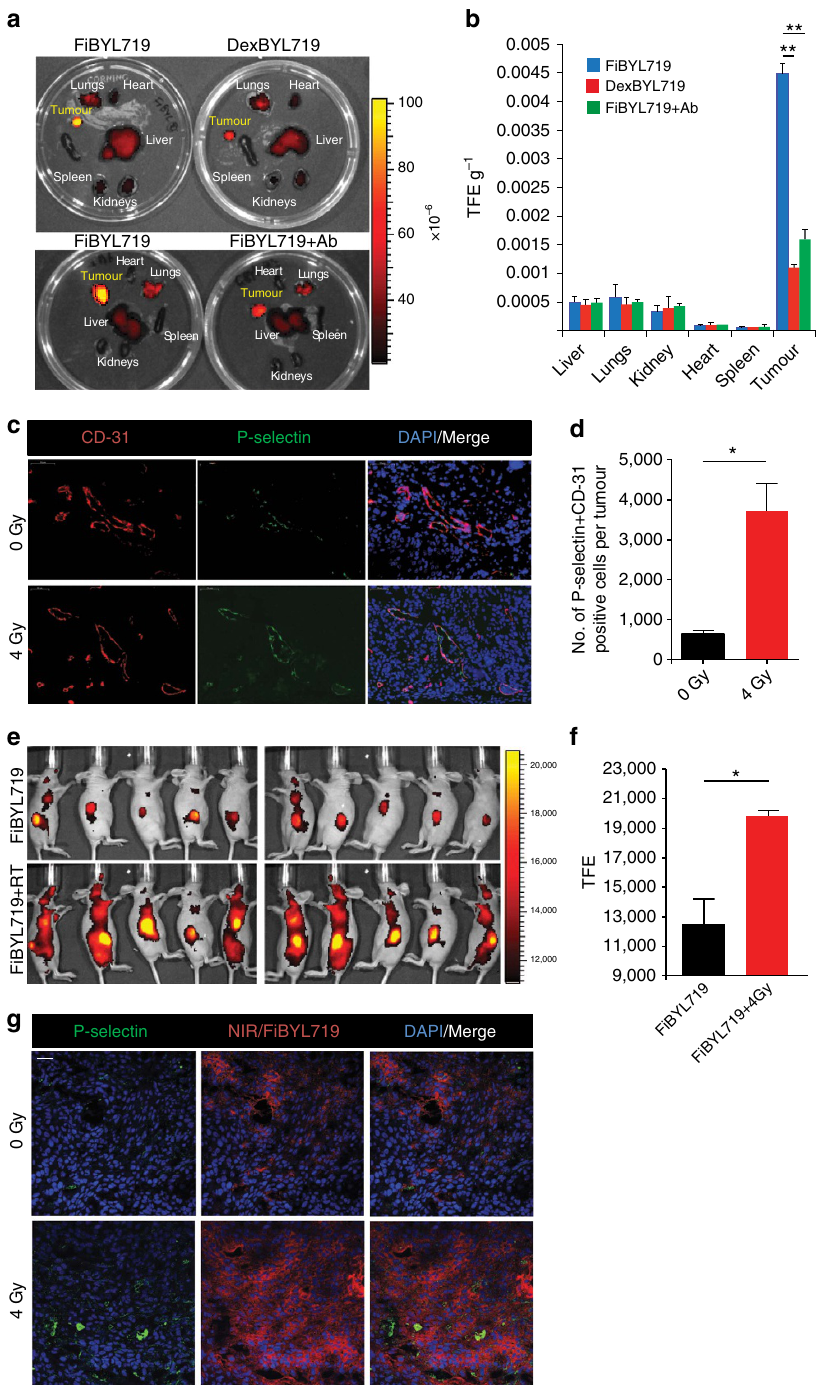
Figure 1 | In-vivo targeting of BYL719-loaded nanoparticles prepared with either fucoidan (Fi) or dextran sulfate (Dex). ( a ) Representative ex vivo fluorescence images of mice organs 24h after i.v. administration of FiBYL719 or DexBYL719 nanoparticles, and pre-treated with anti-P-selectin antibody (Ab). ( b ) Nanoparticle biodistribution in organs and tumour, calculated from ex vivo fluorescence images shown in a as total fluorescence efficiency divided by organ weight ( n ¼ 3). ( c ) Representative immunofluorescence staining for CD-31 (red), P-selectin (green) and DAPI (blue) in Cal-33 xenografts before and after a single dose of ionizing radiation (4Gy). Scale bars, 50 m m. ( d ) Quantification of double-staining positive endothelial cells per tumour shown in c ( n ¼ 3). ( e ) In vivo fluorescence imaging of Cal-33 xenograft-bearing mice 24h after treatment with FiBYL719 or 4Gy RT followed by FiBYL719. ( f ) Quantification of total fluorescence efficiency of tumours shown e ( n ¼ 10). ( g ) Representative immunofluorescence stains of tumour sections for P-selectin (green), NIR (red) and DAPI (blue) from H22 xenografts 24h after treatments. Scale bars, 50 m m. In b , d , f error bars indicate mean ± s.e.m. * P o 0.05, ** P o 0.01; by Mann–Whitney U -test in b or one-way ANOVA with post hoc Tukey test in d , f .